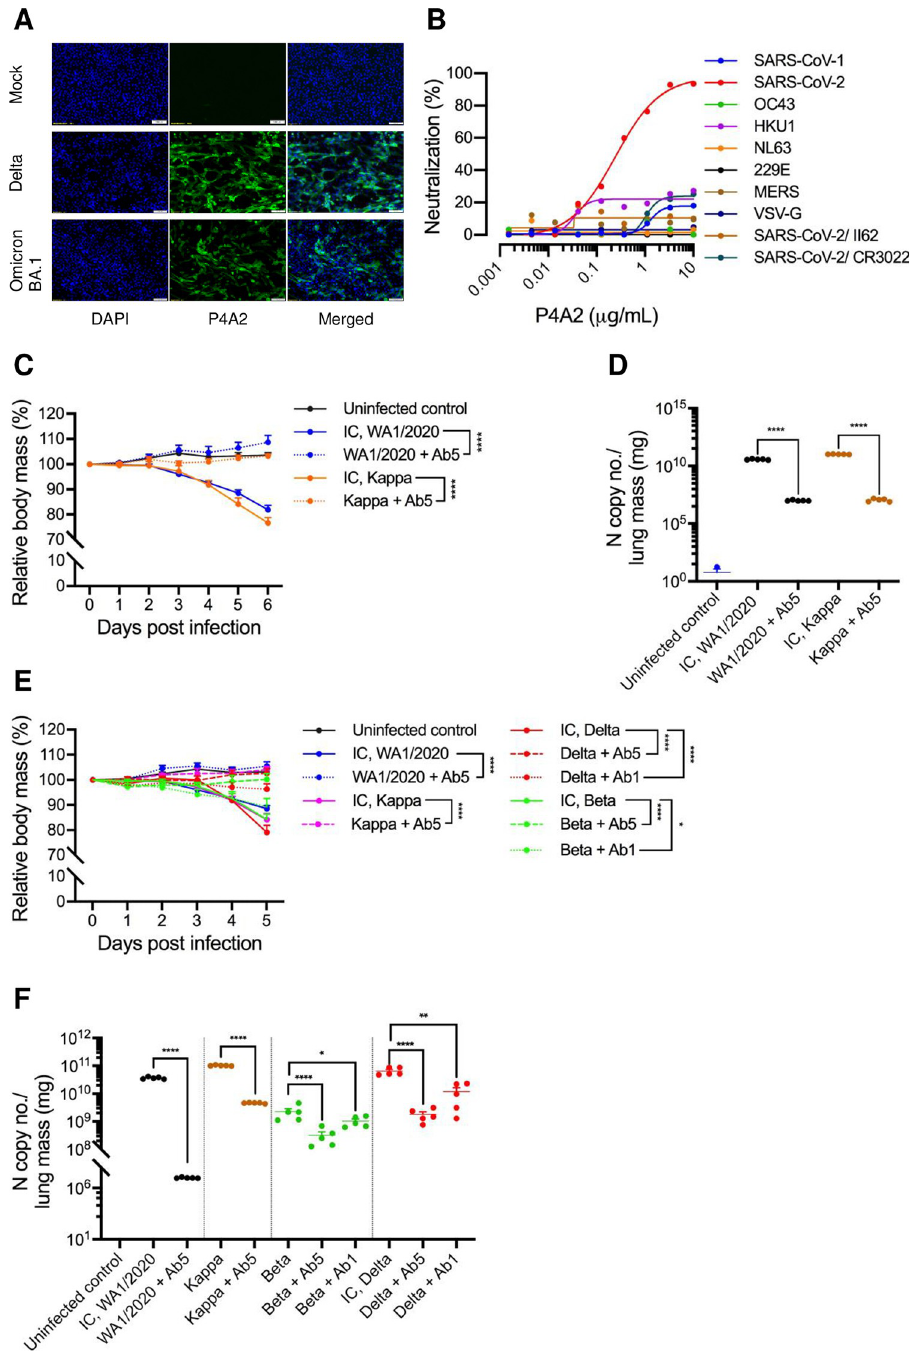
Fig 2. P4A2 protects K18-hACE2 mice against SARS-CoV-2 VOCs. (A) Calu-3 cells were infected with Delta and BA.1 variants of SARS-CoV-2 at a MOI of 0.5. At 24 h post infection, cells were fixed with chilled methanol, stained with P4A2 antibody and visualized by immunofluorescence microscopy. DAPI was used to stain nuclei. Images were captured at a magnification of 10 × . Representative image of uninfected cells ( top row ), Calu-3 cells infected with Delta strain ( middle row ) and Calu-3 cells infected with BA.1 strain of SARS-CoV-2 ( bottom row ). Scale bar represents 100 μ m. (B) Broad spectrum cross-neutralization potential of P4A2 against Alpha and Beta coronaviruses was assessed in pseudotyped viral neutralization assay, SARS-CoV-2 WA1/2020 strain was used in this assay. The P4A2 specifically neutralized SARS-CoV-2 with an IC 50 of 230 ng/mL. (C-F) P4A2 offers low-dose prophylactic and therapeutic protection in the K18-hACE2 mouse model. P4A2 antibody was infused intraperitoneally into mice as a single dose of